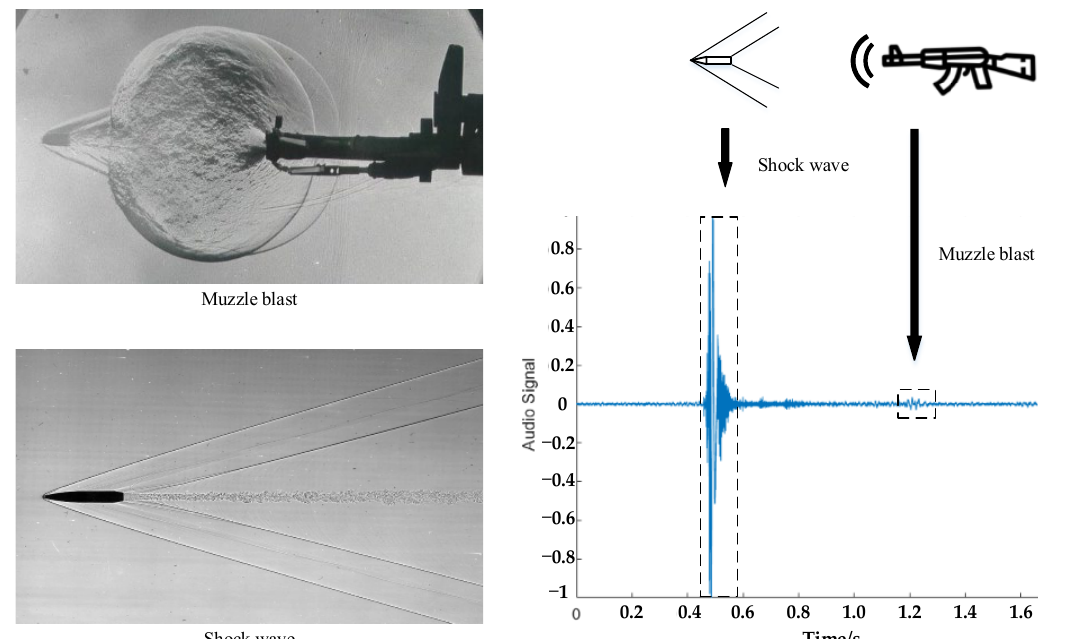
Figure 1. Schematic diagram of a muzzle sound wave.